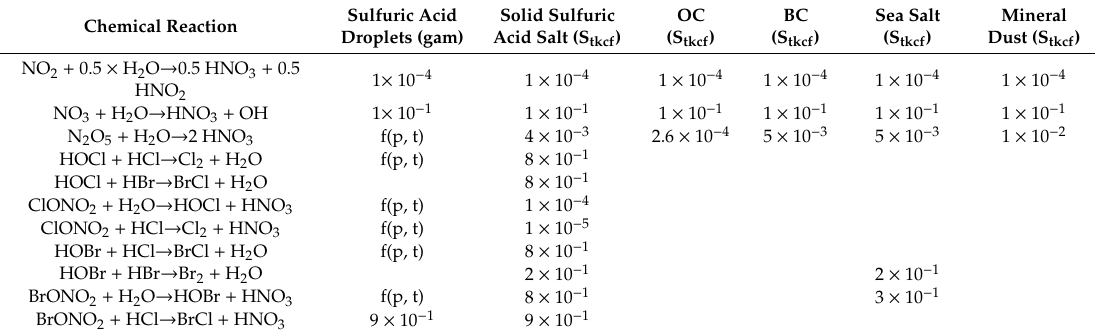
Table 1. Related parameters of heterogeneous chemical reactions on di ff erent aerosols. Sulfuric Acid Solid Sulfuric Chemical Reaction Droplets (gam) Acid Salt (S tkcf